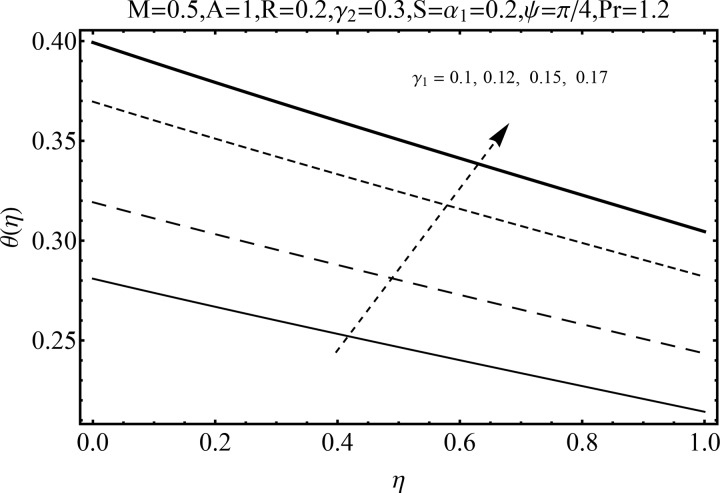
Influence of γ1 on θ(η).